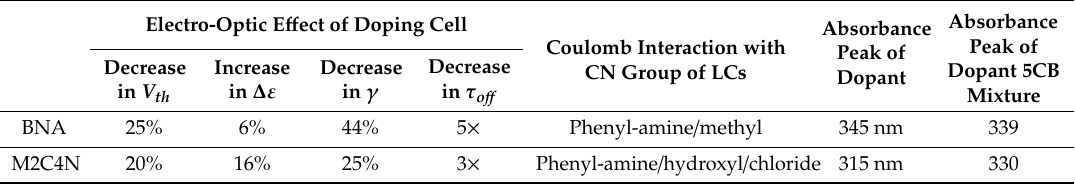
Table 3. Summary of BNA and M2C4N